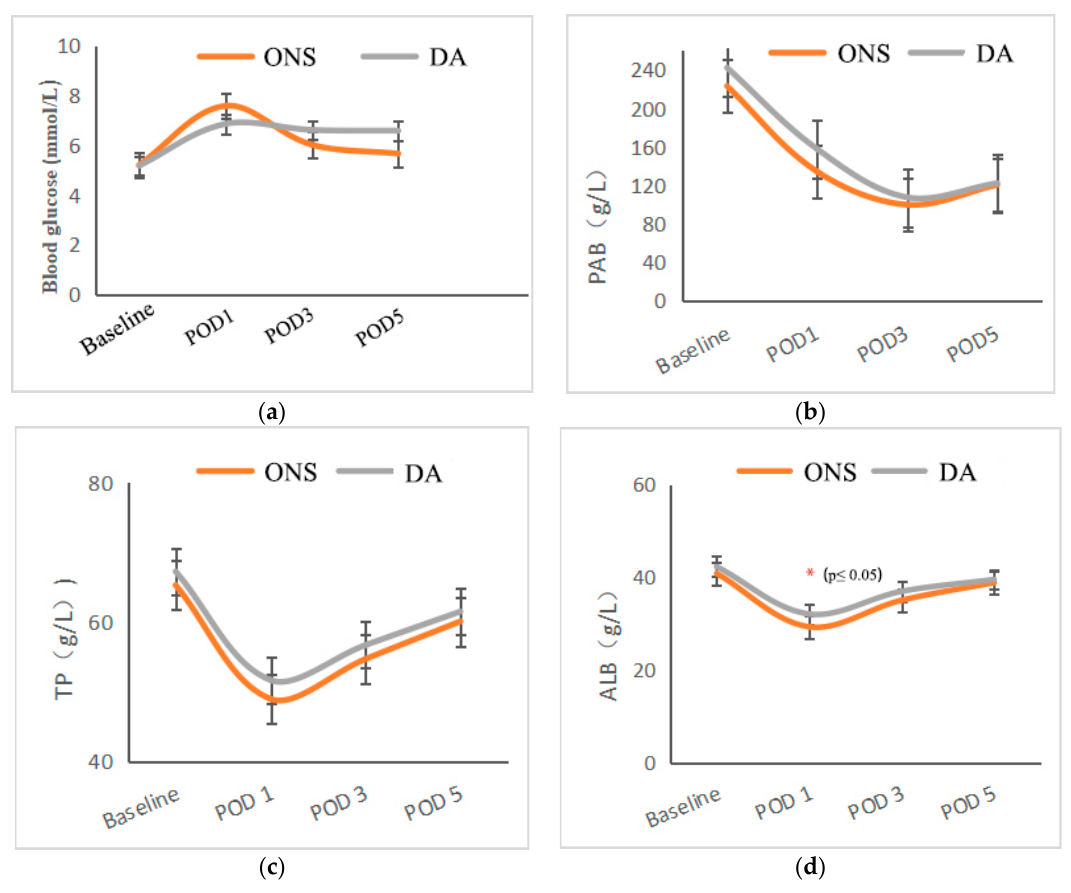
Figure 2. ( a ) Patterns from parenteral nutrition to oral overfeeding. ( b ) Average daily tube feeding amount of experimental group and control group after operation. ( c – h ) Abdominal distension, abdominal pain, nausea/vomiting and heartburn/reflux symptom scores were compared between experimental group and control group after operation. ( g ): Proportion of each symptom score in the total scores of gastrointestinal symptoms after surgery. ( h ): Postoperative mean daily total score of gastrointestinal symptoms.